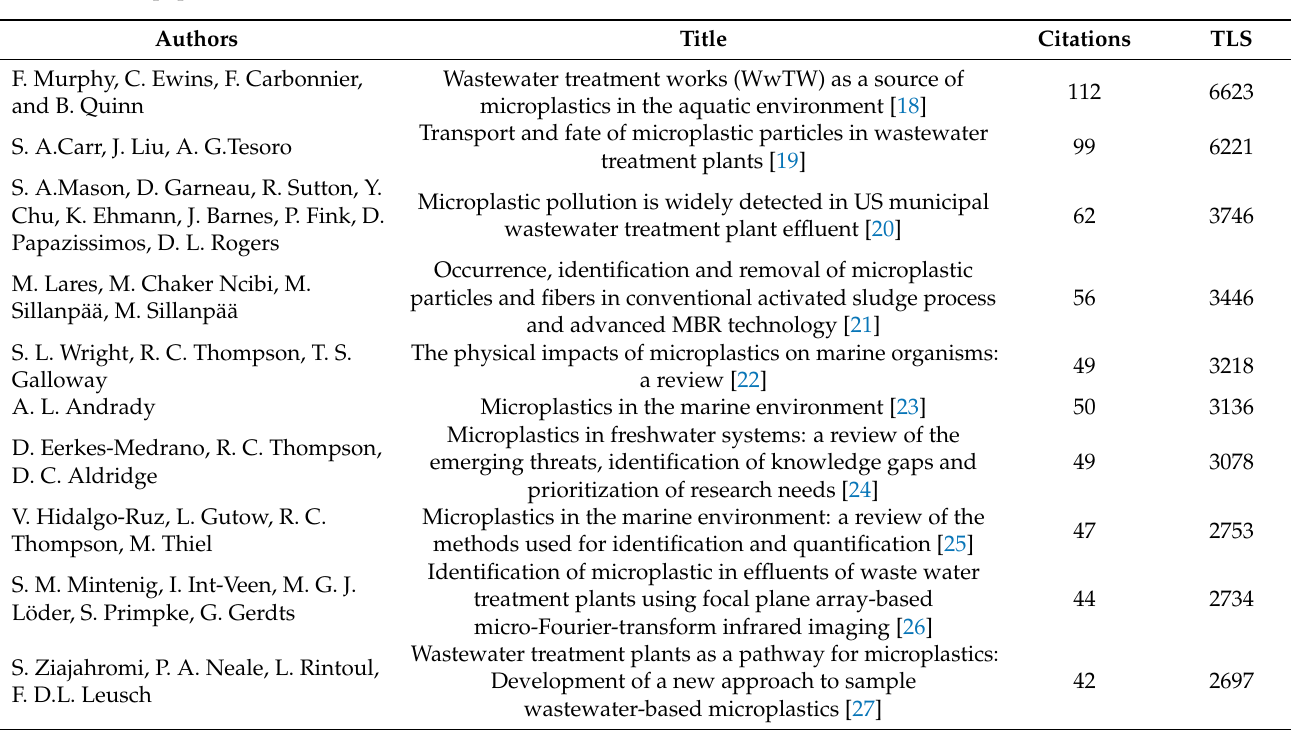
Table 2. The top-10 most cited articles in the References of the 931 papers derived from the query Q2; TLS represents the total number of times that the article appears in the Reference Lists together with any other article of the whole class of examined